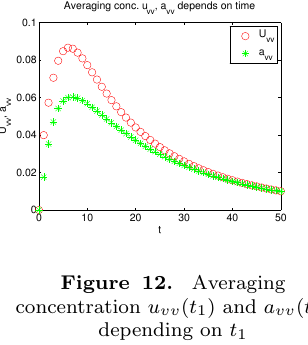
Figure 12. Averaging concentration u vv ( t 1 ) and a vv ( t 1 ) depending on t 1